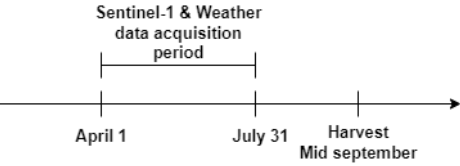
Figure 4. The Sentinel-1 and weather data were collected from the first of April until the end of July. This end date is approximately a month before harvest, which for winter wheat typically occurs in mid-September in Sweden. In general, however, we only retained a single contribution per week from each of our three input data sources (Sentinel-1, weather, or topography). For Sentinel-1, this was performed by selecting the first RFI-free image from that week. For weather, the daily measurements were accumulated over the whole